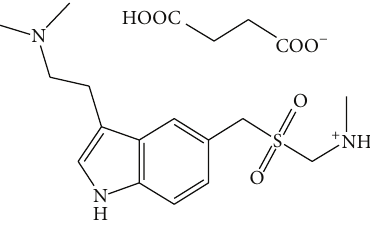
Figure 1: Structure of